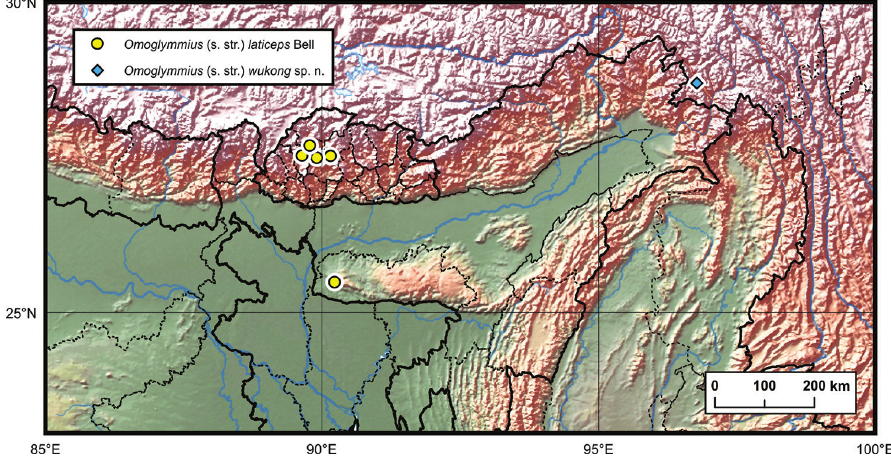
Figure 7. Distribution of Omoglymmius ( s. str. ) species from the Himalayan